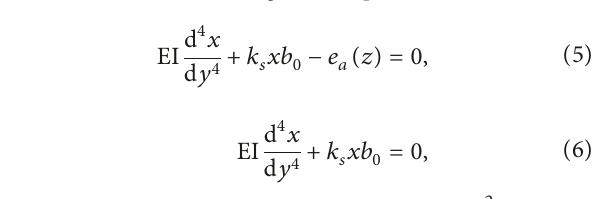
Figure 1: Stress mode diagram of a pile-anchor